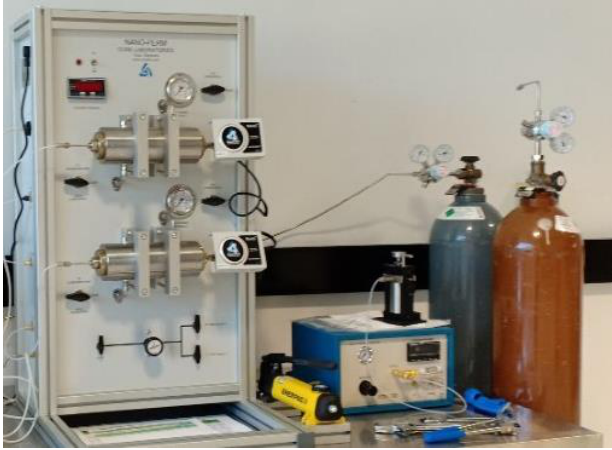
Fig. 2. Pictorial representation of the instrument for permeability and porosity